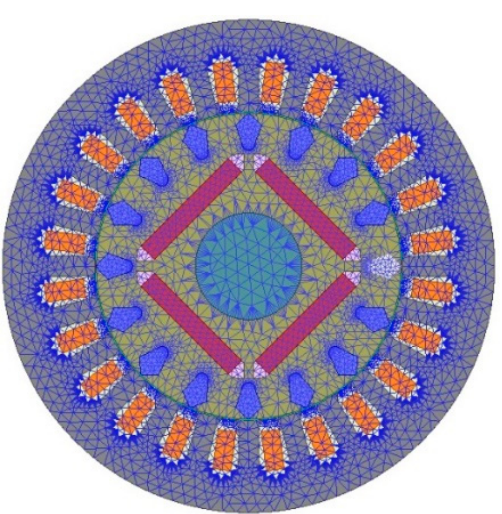
Figure 7. Cross-section of LS-PMSM with mesh plotting.